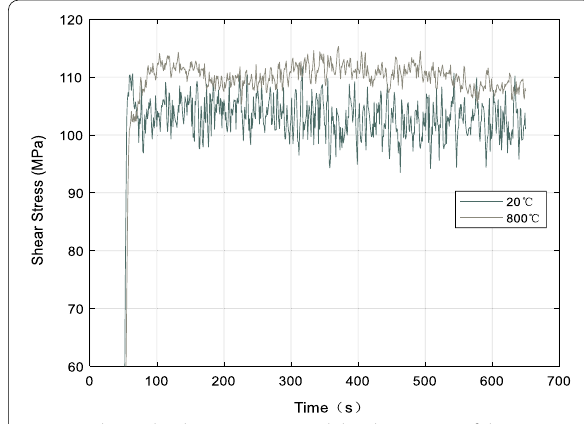
Fig. 8 Relationship between time and the shear stress of the calcareous sand before and after heat treatment